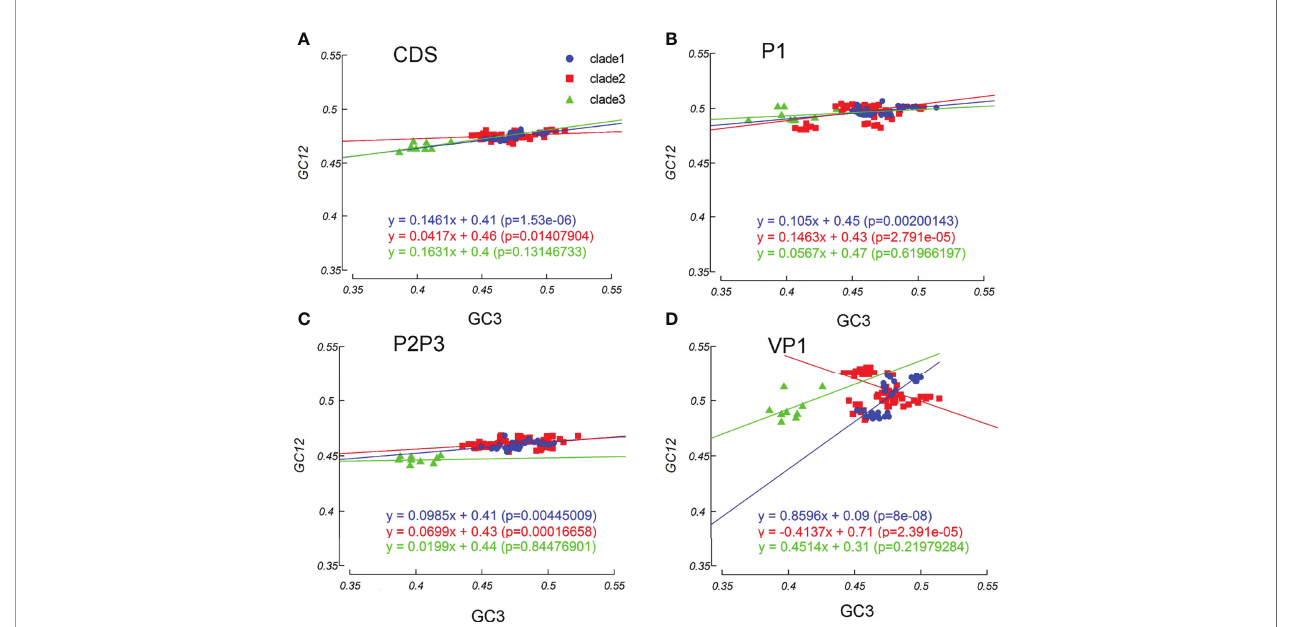
FIGURE 7 | Neutrality plot analysis. Neutrality plots (GC12 and GC3) was constructed for the coding sequences, P1 and P2P3 regions of EV-A strains. (A) coding sequences, (B) P1 region, (C) P2P3 region, (D) VP1 gene. The blue dots, red squares, and green triangles indicate clade 1, clade 2 and clade 3 strains.